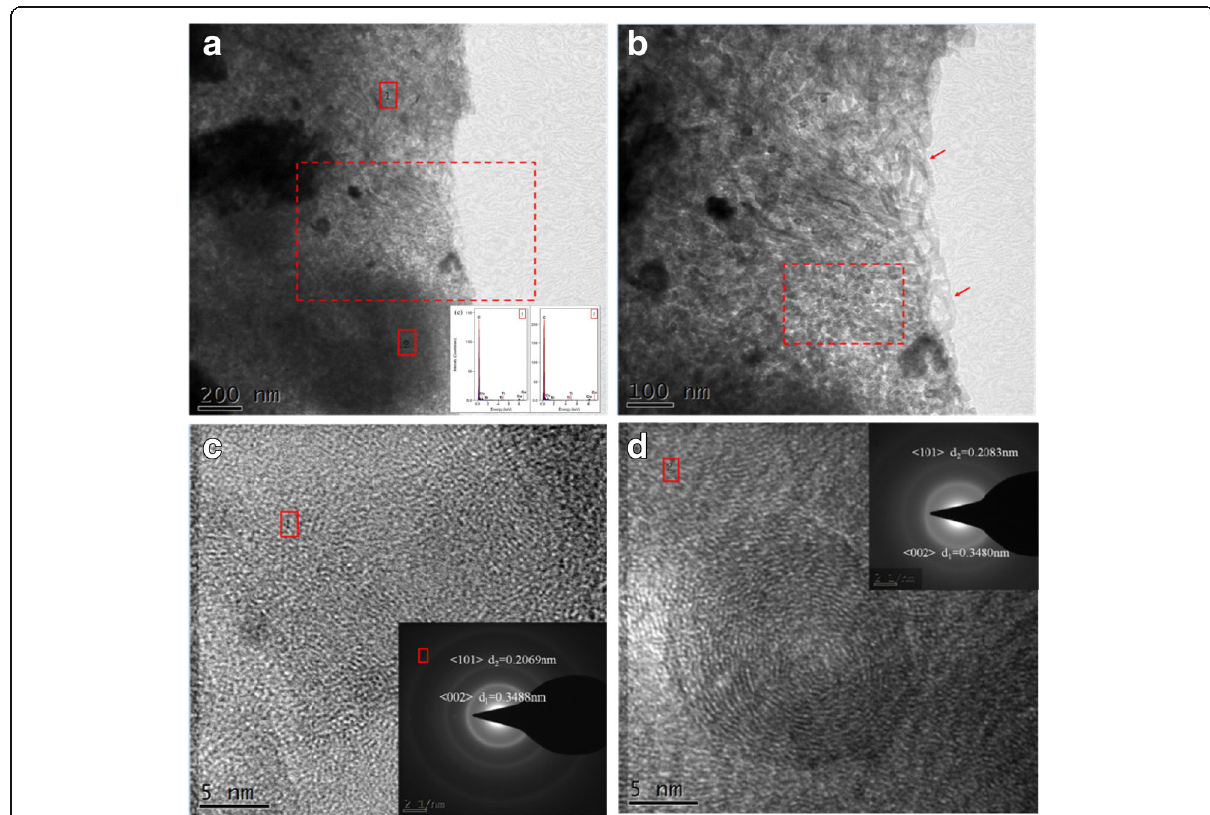
Fig. 6 a – d TEM image in sintered nanocomposites with 0.5 wt% graphenes and 0.5 wt% MWCNTs. a TEM image showing nano-Carbon micro- structure in Cu; b Magnified TEM image of Fig. 6a; c High resolution TEM image analysis taken from the marked cross symbol spots 1 in Fig. 6a; d High resolution TEM image analysis taken from the marked cross symbol spots 2 in Fig. 6a. Inserted in a is EDS spectra taken from the marked cross symbol spots 1and 2